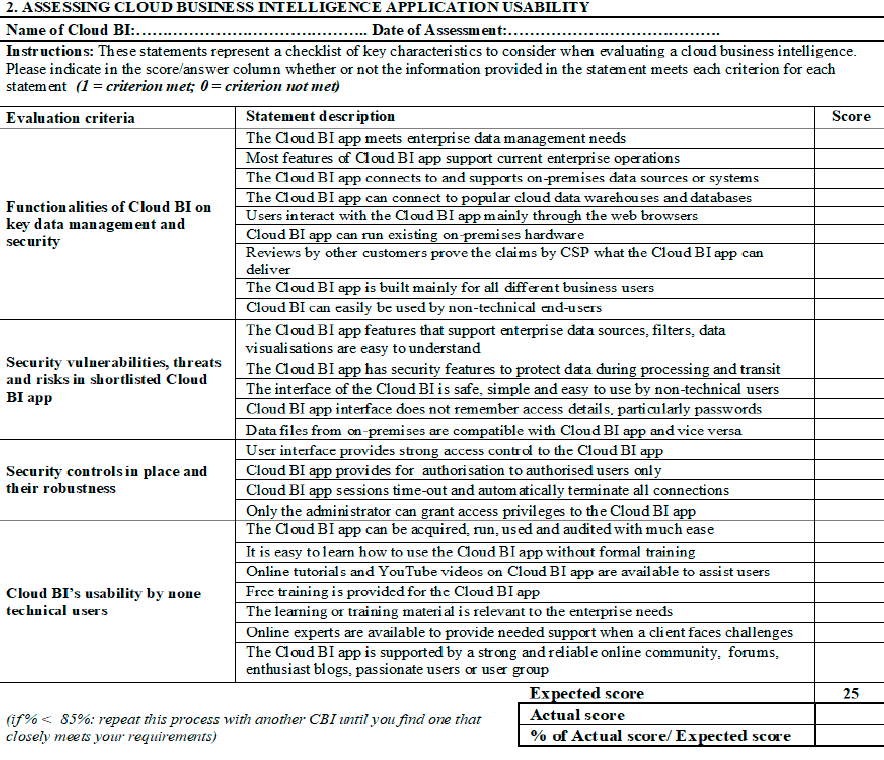
Figure 9. Checklist for assessing Cloud BI’s operational and security usability.